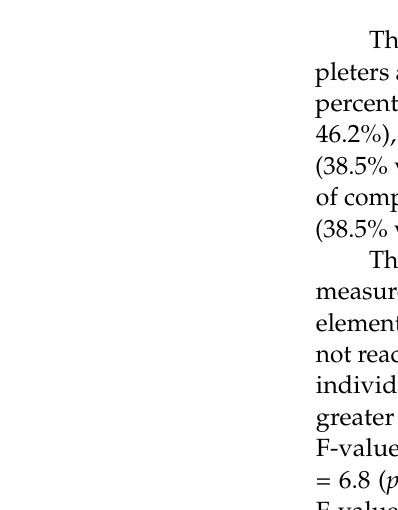
Table legend: No., number; SD, standard deviation; CI, 95% confidence interval; * p -value of <0.05 denoting statistical significance; a comorbidities, including type 2 diabetes, cardiovascular disease, hypertension, hyperc- holesterolemia, depression, osteoarthritis, asthma, obstructive sleep apnoea, reflux, and